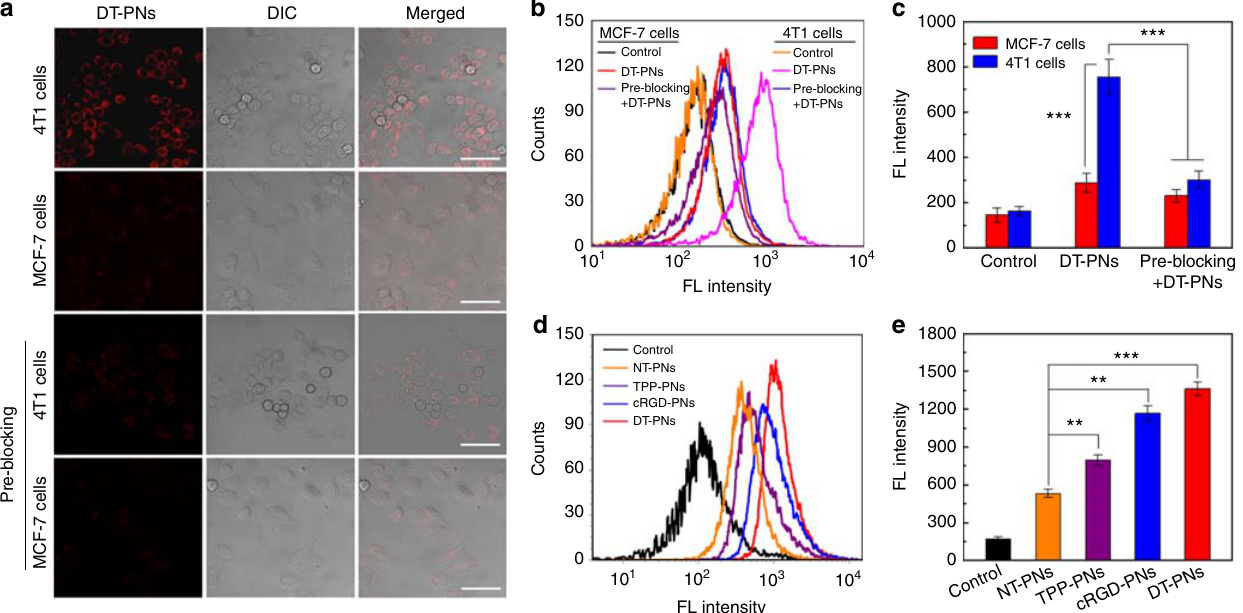
Fig. 3 Cancer cell targeting property of DT-PNs. a CLSM images of 4T1 cells (integrin positive) and MCF-7 cells (integrin negative) after incubating with RhB-labelled DT-PNs under different treatments for 2 h at 37 °C. For the pre-blocking experiment, cells were pretreated with 2 μ M free cRGD for 30 min before incubation with DT-PNs (scale bar, 50 μ m). b , c Flow cytometry analysis and the statistical analysis in a . The mean value was calculated by the t test (mean ± s.e.m. n = 3). *** p < 0.001, compared with the indicated group. d Flow cytometry analysis of 4T1 cells upon 6 h treatment with RhB-labelled polyprodrug nanoparticles with diverse targeting moieties, including non-targeting nanoparticles (NT-PNs) from the assembly of PDMA- b -PCPTSM and PDMA- b -P(CPTSM- co -RhB); TPP-PNs from the assembly of TPP-PDMA- b -PCPTSM and PDMA- b -P(CPTSM- co -RhB), cRGD-PNs from the assembly of cRGD-PDMA- b -P(CPTSM- co -RhB) and PDMA- b -PCPTSM, and the fi nal resultant DT-PNs. e Statistical analysis of the mean fl uorescence intensity in b . The mean value was calculated by the t test (mean ± s.e.m. n = 3). ** p < 0.01, *** p < 0.001, compared with the indicated